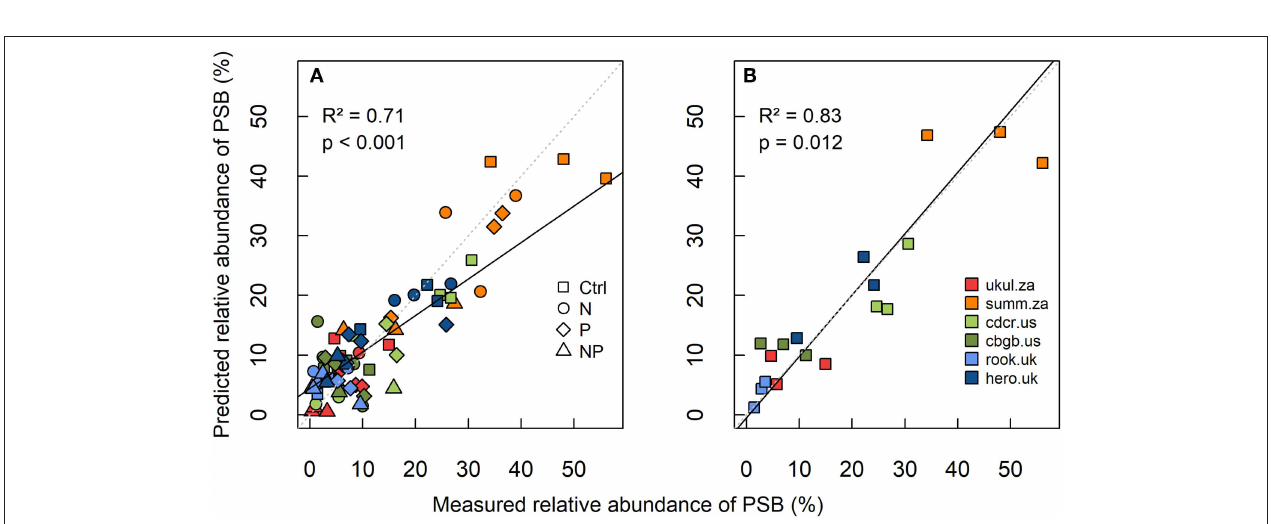
FIGURE 2 | Linear mixed-effects model of (A) relative abundance of phosphorus-solubilizing bacteria (PSB) in all treatments, and (B) relative abundance of PSB in the control at all six grassland sites in 0–15cm depth. Measured relative abundance of PSB is shown on the x-axis and predicted relative abundance of PSB (best model predictors: total organic carbon-to-total phosphorus ratio, sand content, soil pH, and water extractable phosphorus, Table S2 ) is shown on the y-axis. The linear mixed-effects model was calculated after multi-model selection. R ² was calculated as conditional R ² according to Nakagawa and Schielzeth (2013), the standard line is dashed (intercept = 0, slope = 1), and the fitted line of the model is solid.